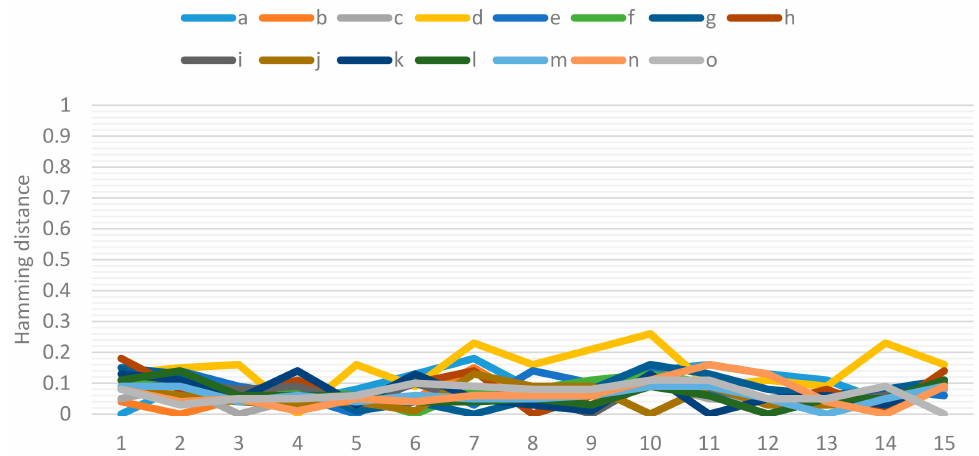
Figure 2. Hamming distance between experts in cause–cause relationships. Source: own elaboration.